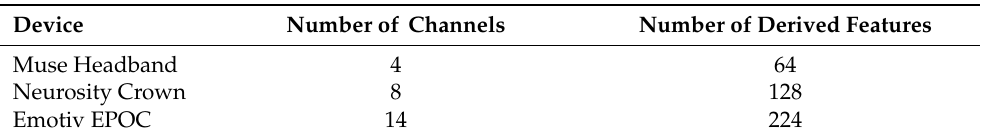
Table 2. Number of channels and derived features for each device: Muse Headband: 64 features; Neurosity Crown: 128 features; Emotiv EPOC: 224